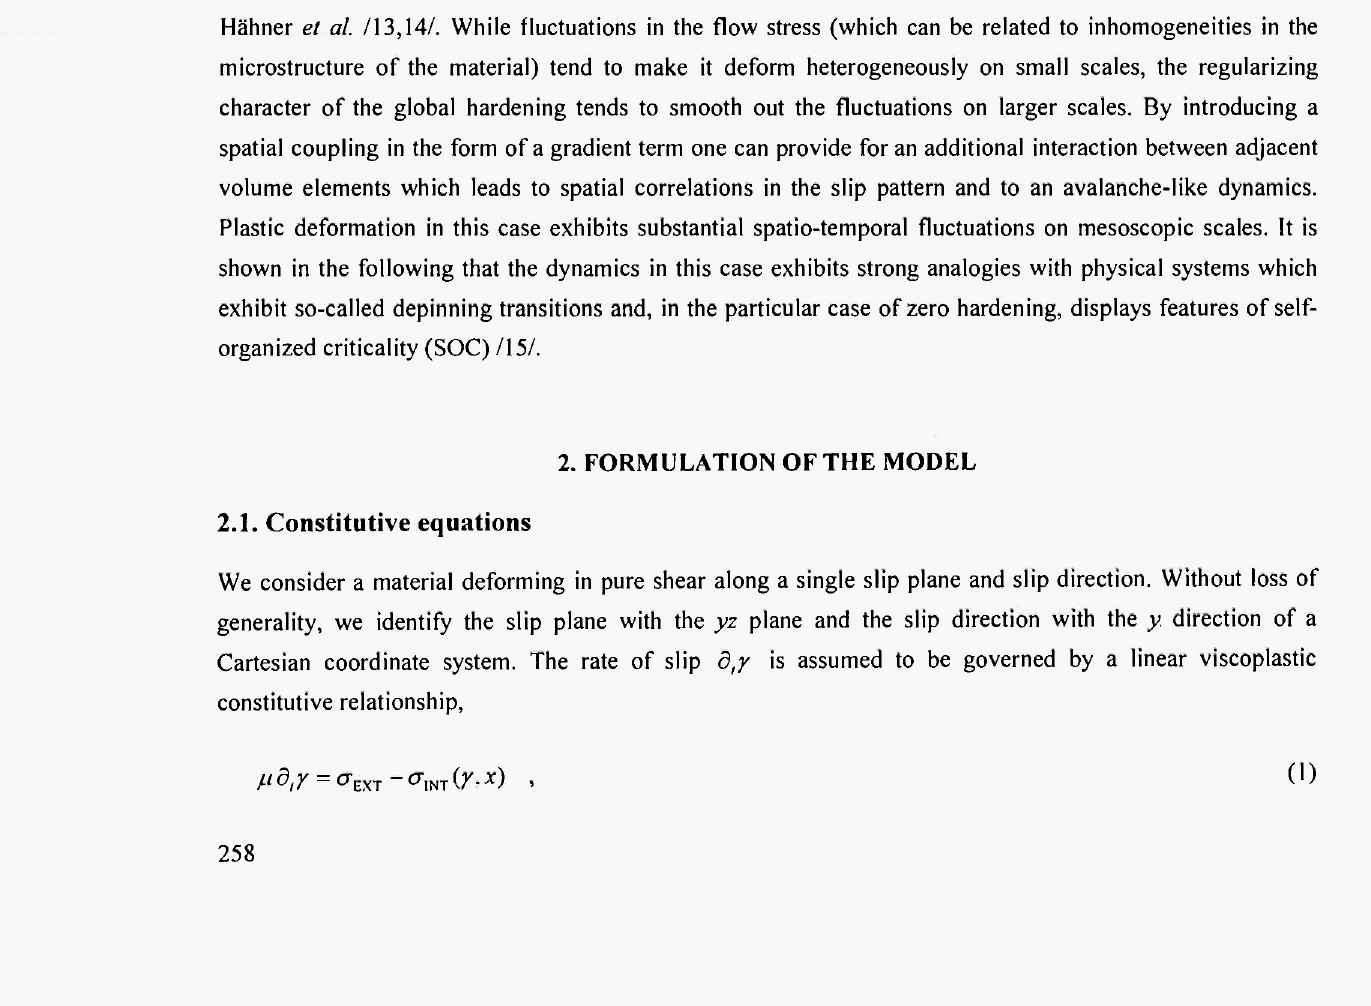
Fig. 3: Distribution of energy releases in acoustic emission 'events' recorded during creep deformation of ice single crystals; temperature T= 263 K, resolved shear stresses on the basal plane as indicated in the inset. Over several orders the data follow a power law p(E) ~ E~ 16 . After Miguel et al. /12/.